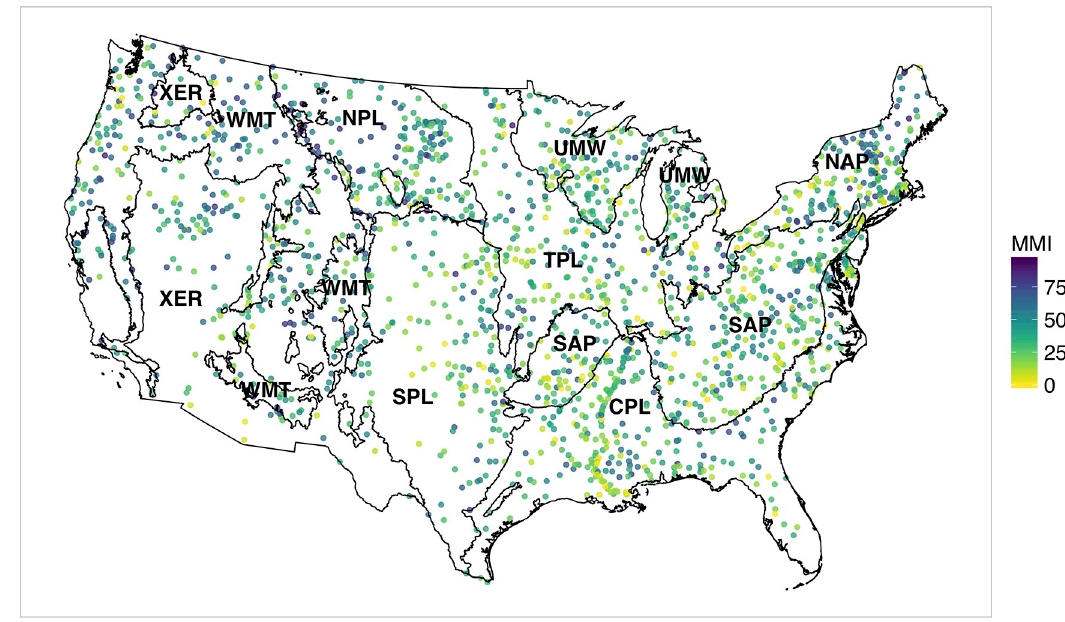
Fig 1. Locations of 2008/09 NRSA stream sites with point colors corresponding to sampled MMI scores. Ecoregions: Coastal Plains (CPL), Northern Appalachians (NAP), Northern Plains (NPL), Southern Appalachians (SAP), Southern Plains (SPL), Temperate Plains (TPL), Upper Midwest (UMW), Western Mountains (WMT), and Xeric